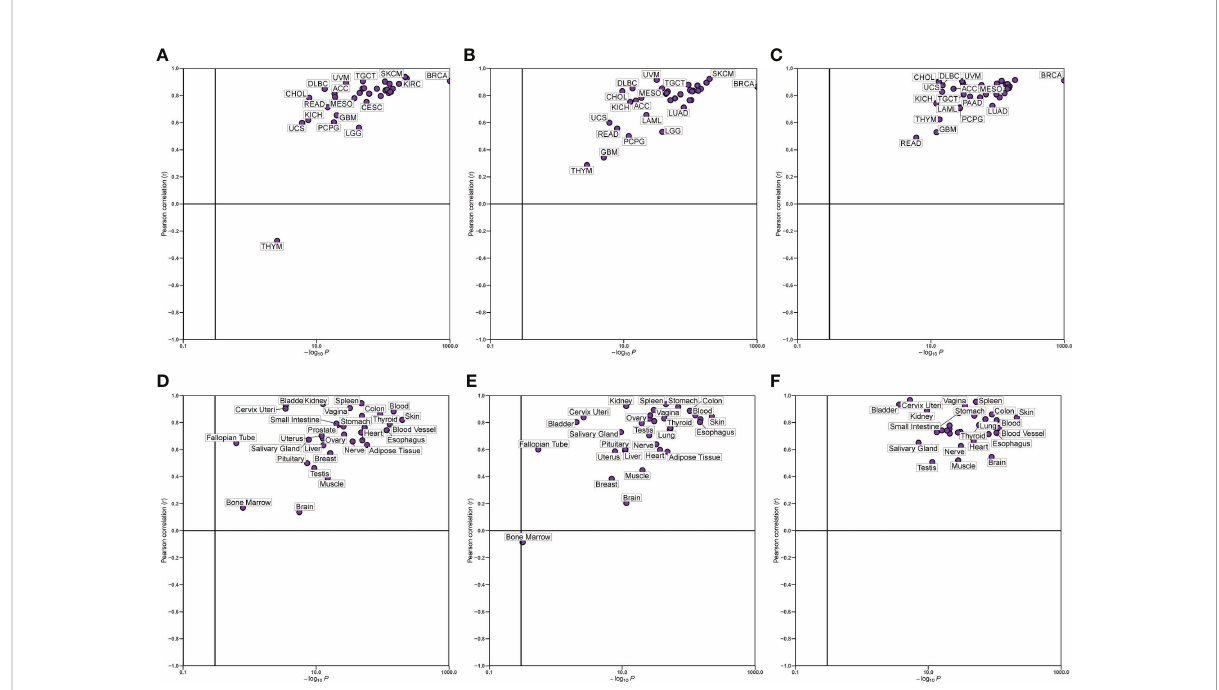
FIGURE 7 Relationship between the expression levels of three hub genes. (A-C) In different cancer types. (D-F) In normal tissues.